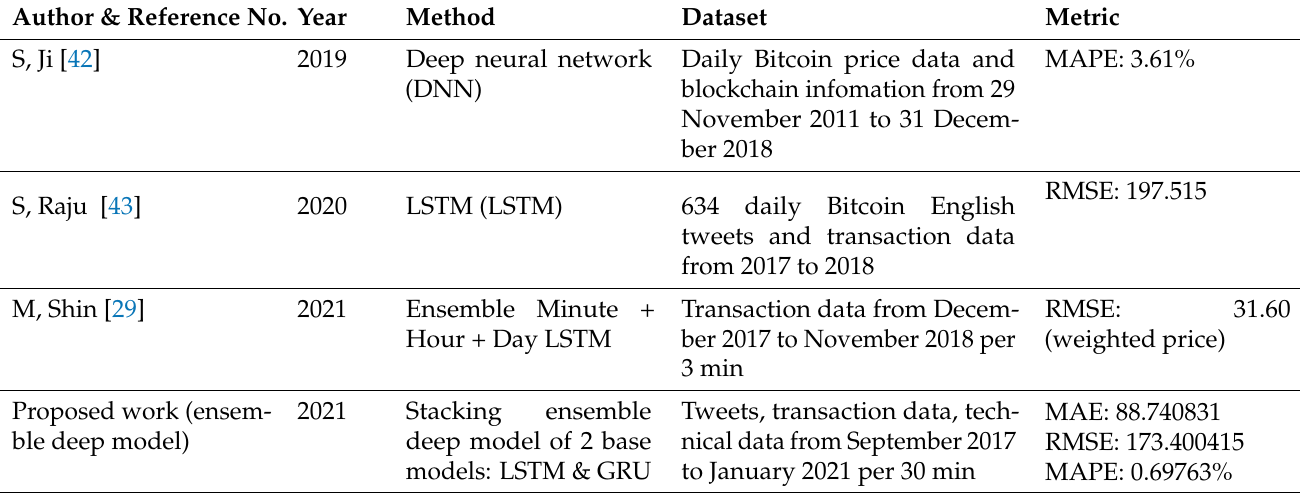
Table 8. Comparison of the proposed method and previous methods in Bitcoin price